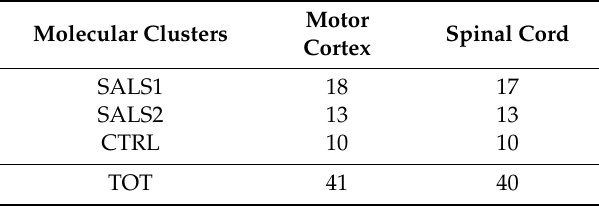
Table 1. Number of samples processed for sporadic amyotrophic lateral sclerosis (SALS) patients’ molecular clusters and regions on the central nervous system